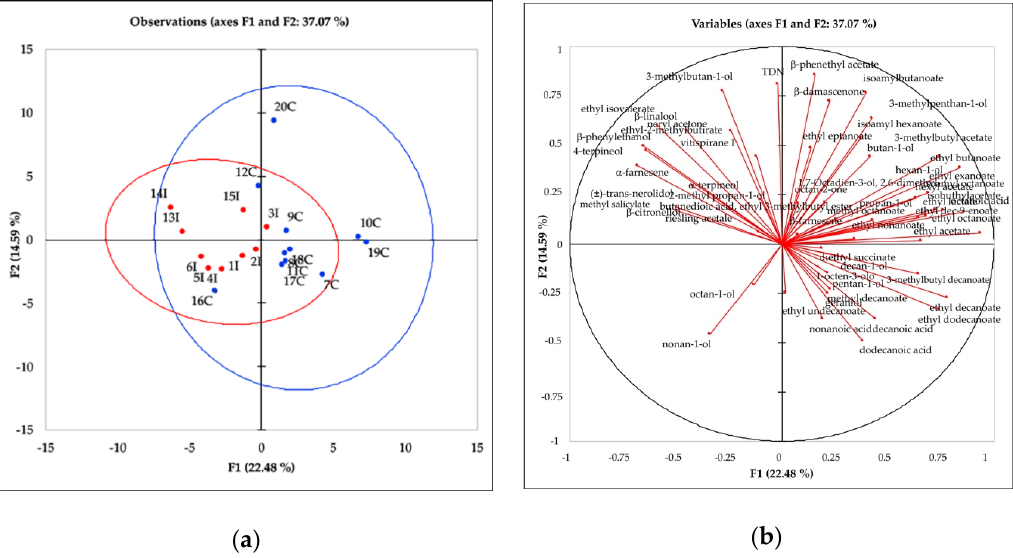
Figure 2. Principal component analysis (PCA) scores ( a ) and loadings ( b ) plots of identity profile (volatile compounds) for Sangiovese wines from Italy (in red) and California (in blue) from 2017 harvest. See Table 1 for the wine